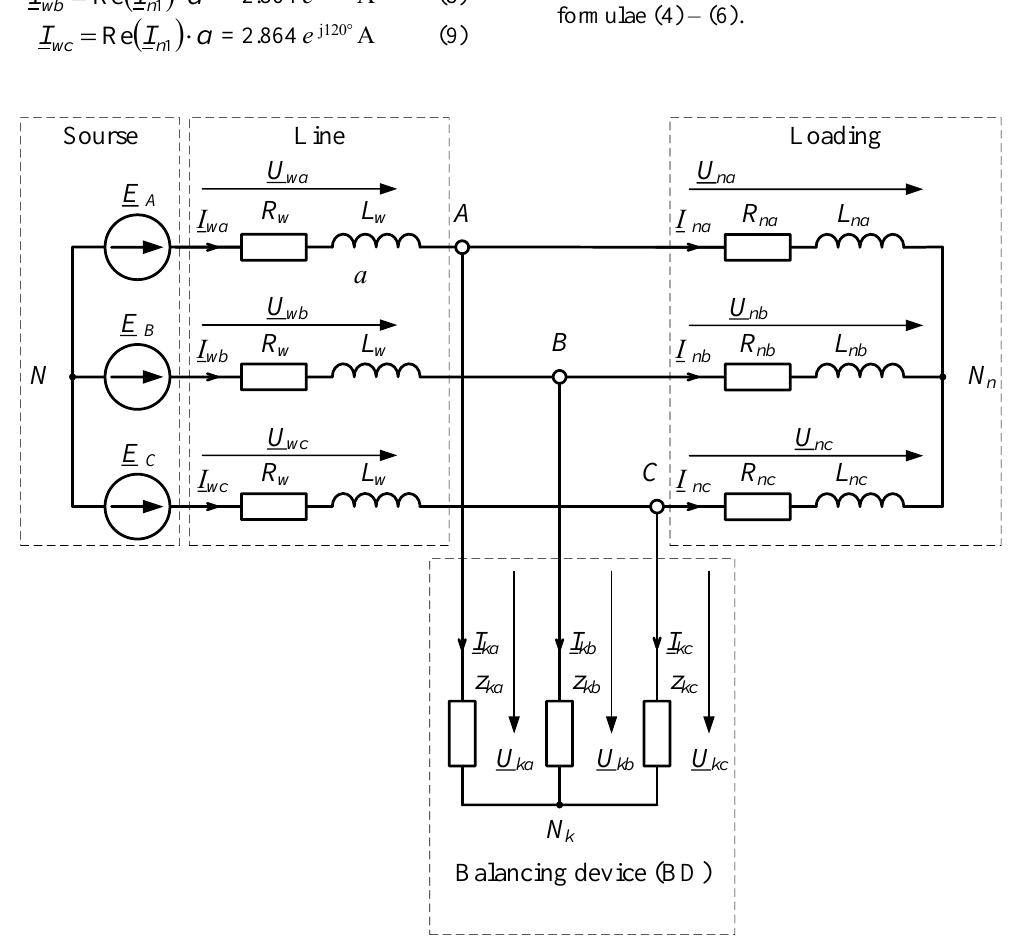
Figure 2. Equivalent diagram of three-phase system of power supply with abalanced load and connected balancing device